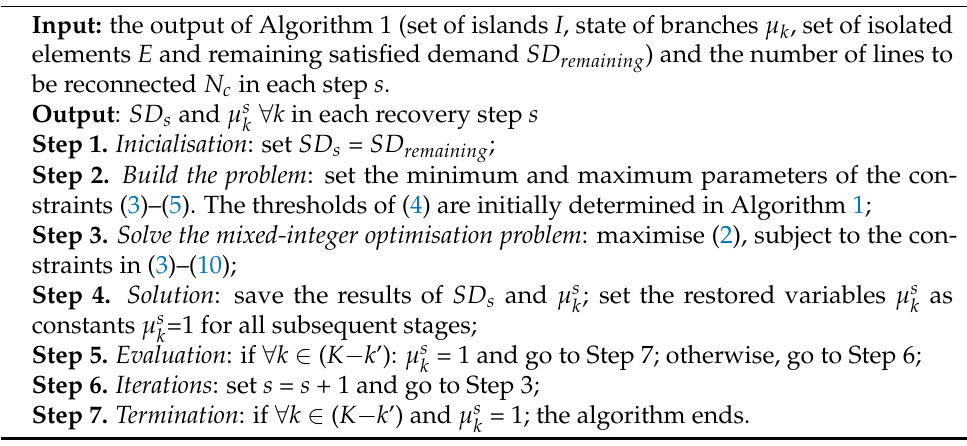
Algorithm 2: Recovery process. Mixed-integer optimisation